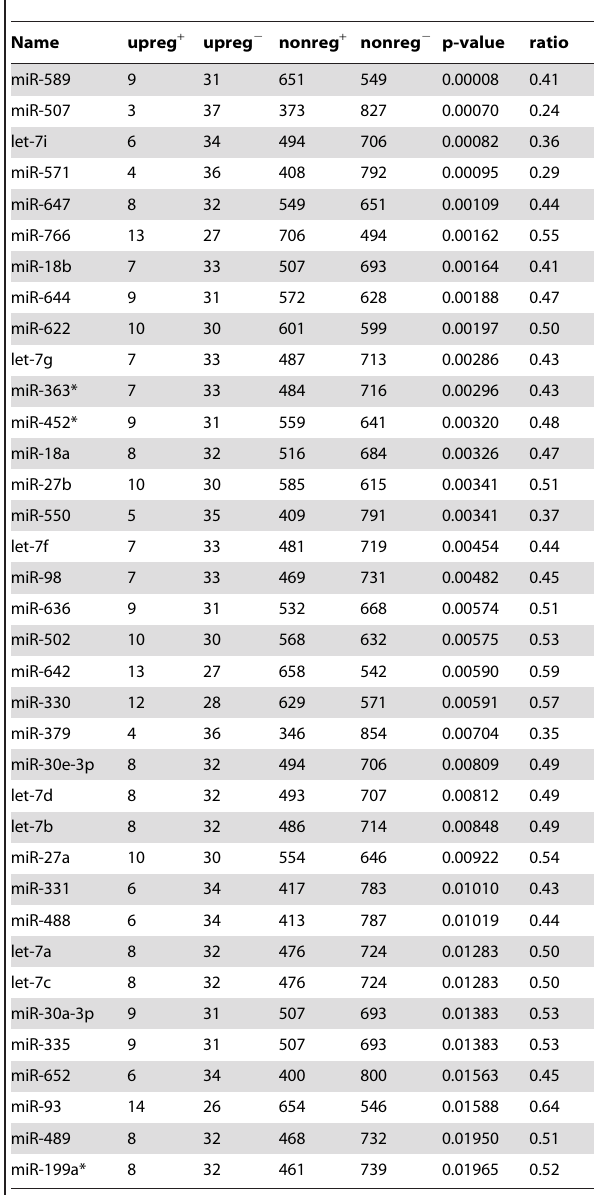
Table 5. Highly upregulated mRNAs show mostly negative selection (site avoidance) for miRNA binding